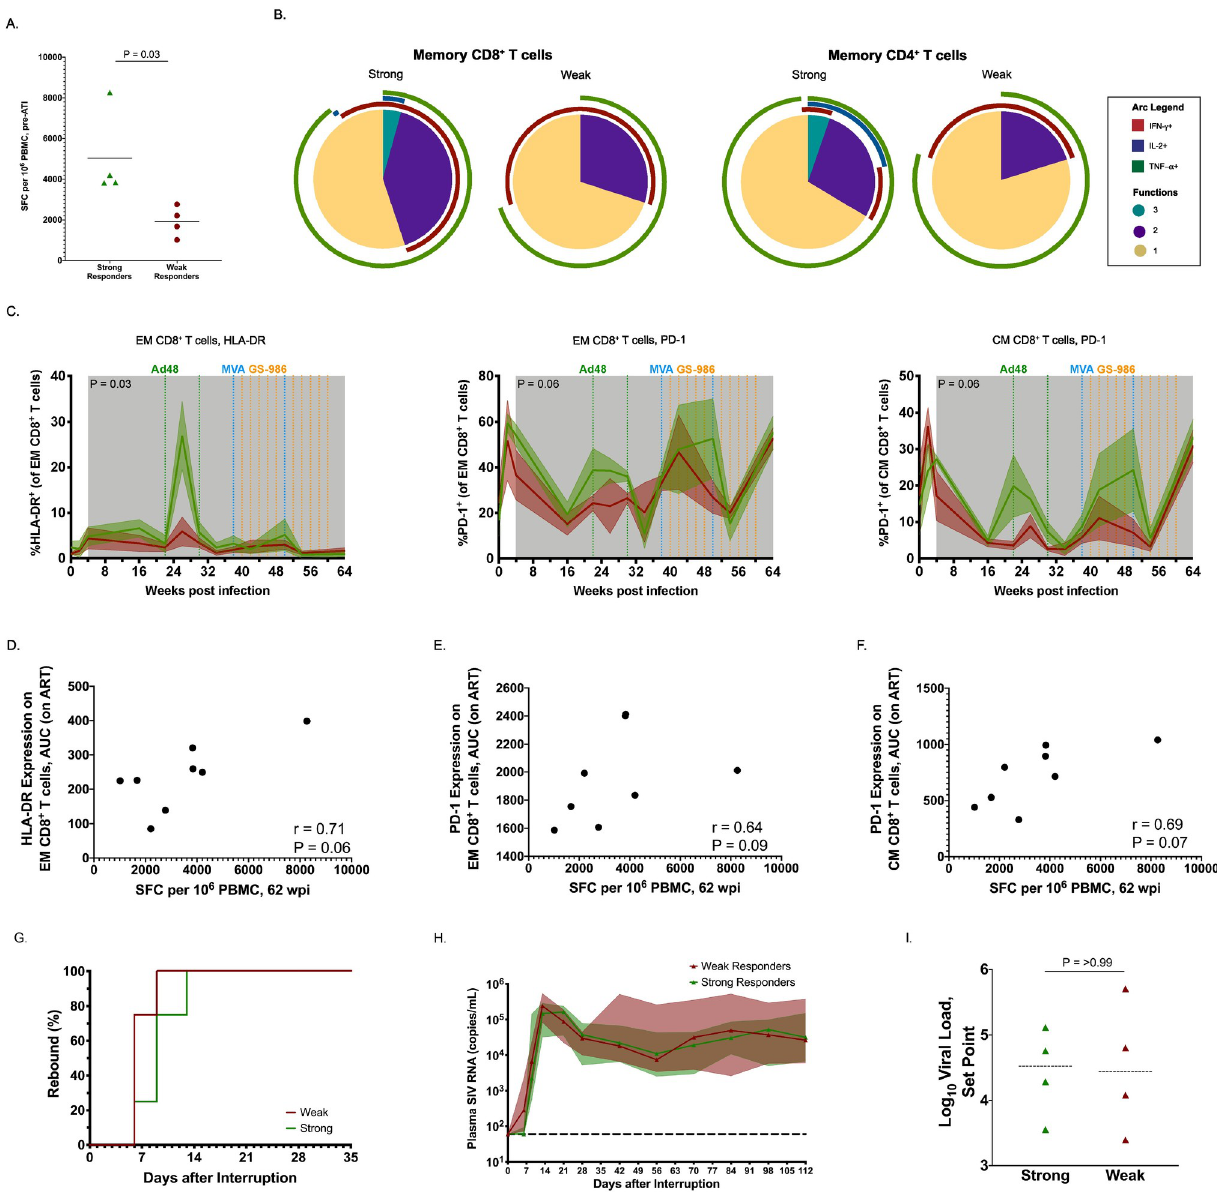
Fig 9. Comparison of strong and weak cellular vaccine response within TV+TLR7 infant RMs. (A) Magnitude of anti-SIV cellular immunity measured by IFN- γ ELISPOT prior to ATI at 62 weeks post infection of strong and weak responders. Dashed bars represent median. Groups were compared using a two-sided Mann-Whitney test (P < 0.05 was considered significant). (B) Pie charts depicting the ability of memory CD8 + and CD4 + T cells isolated from strong and weak TV+TLR7 responders to produce IFN- γ , IL-2 and/or TNF- α in response to stimulation with SIVmac239 Gag peptide pool at 52 weeks post infection (n = 4). (C) Longitudinal analysis of HLA-DR and PD-1 expression on effector memory (EM) and central memory (CM) CD8 + T cells in strong and weak responders within TV+TLR7 RMs (n = 8). The shaded area represents the period of ART treatment. AUC on ART was compared between groups using a two-sided Mann-Whitney test. (P < 0.05 was considered significant) Association between (D) HLA-DR expression on EM, (E) PD-1 expression on CM, and (F) PD-1 expression on EM CD8 + T cells during ART represented by AUC and magnitude of SIV-specific T cells following end of vaccine regimen prior to ATI measured by ELISPOT in TV+TLR7 RMs. Two-sided Spearman rank correlation test was used to determine statistical significance. R value indicates correlation coefficient. (G) Comparison of time to viral rebound in strong and weak TV+TLR7 responder RMs depicted by Kaplan-Meier curves. (H) Median longitudinal plasma SIV RNA levels between strong and weak responders following ATI. The solid line represents the median, the shaded area represents interquartile range, and the horizontal dashed line represents the limit of detection of the assay. (I) Set point viremia following 16 weeks of ATI of strong and weak TV+TLR7 responders determined by the mean of the final three viral load measurements. Dashed bars represent median. Groups were compared using a two-sided Mann-Whitney test (P < 0.05 was considered significant).